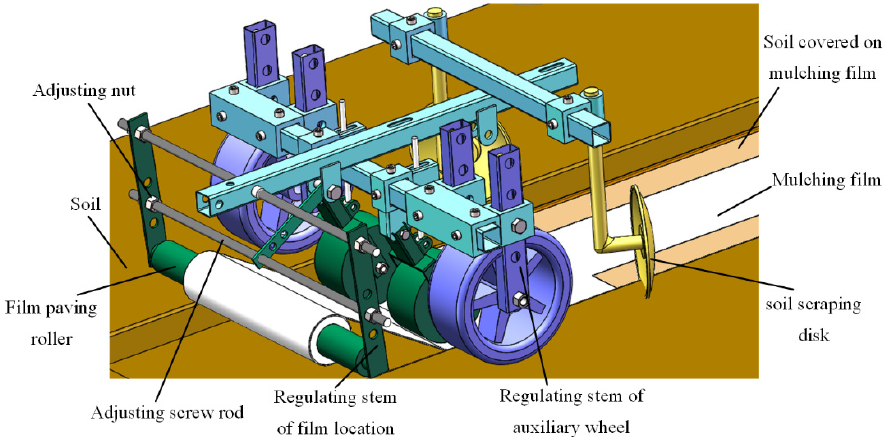
Figure 9. The structure of the mulching film part.